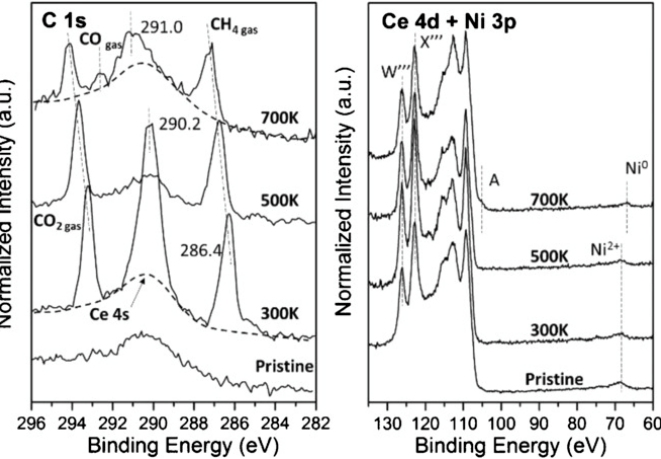
Figure 2. C 1s and Ce 4d + Ni 3p spectra of the Ni/CeO 2 (111) catalyst ( Θ Ni ~ 0.1 ML) surface under 0.13 mbar CH 4 and 0.13 mbar CO 2 at di ff erent temperatures. Reprinted with permission from 0.13 mbar CH 4 and 0.13 mbar CO 2 at different temperatures. Reprinted with permission from [143],